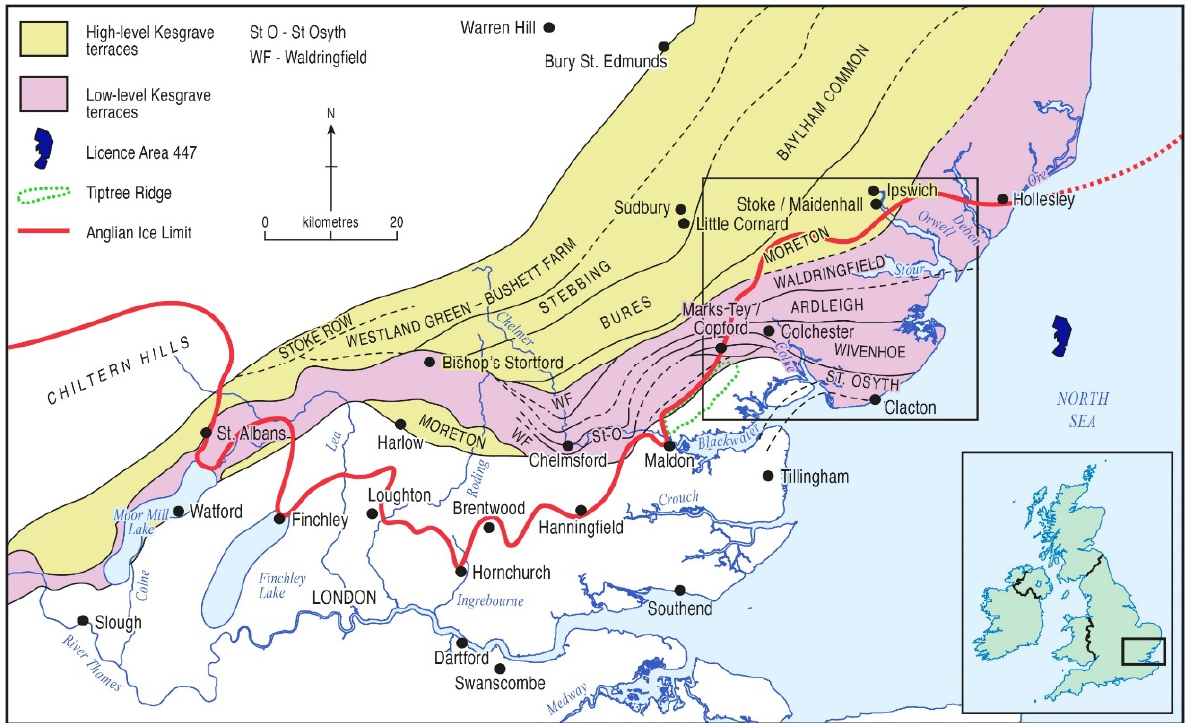
Figure 1. Location of the study area (as depicted in Figure 3—see box). Pre-diversion Thames fluvial archives are illustrated (modified from [12,13]). Also shown are Licence area 447 (see text), the Anglian (MIS 12) glacial limit and palaeolakes formed at its margin in the London area (see also Figure 2) and locations mentioned in the text that do not appear in other figures.